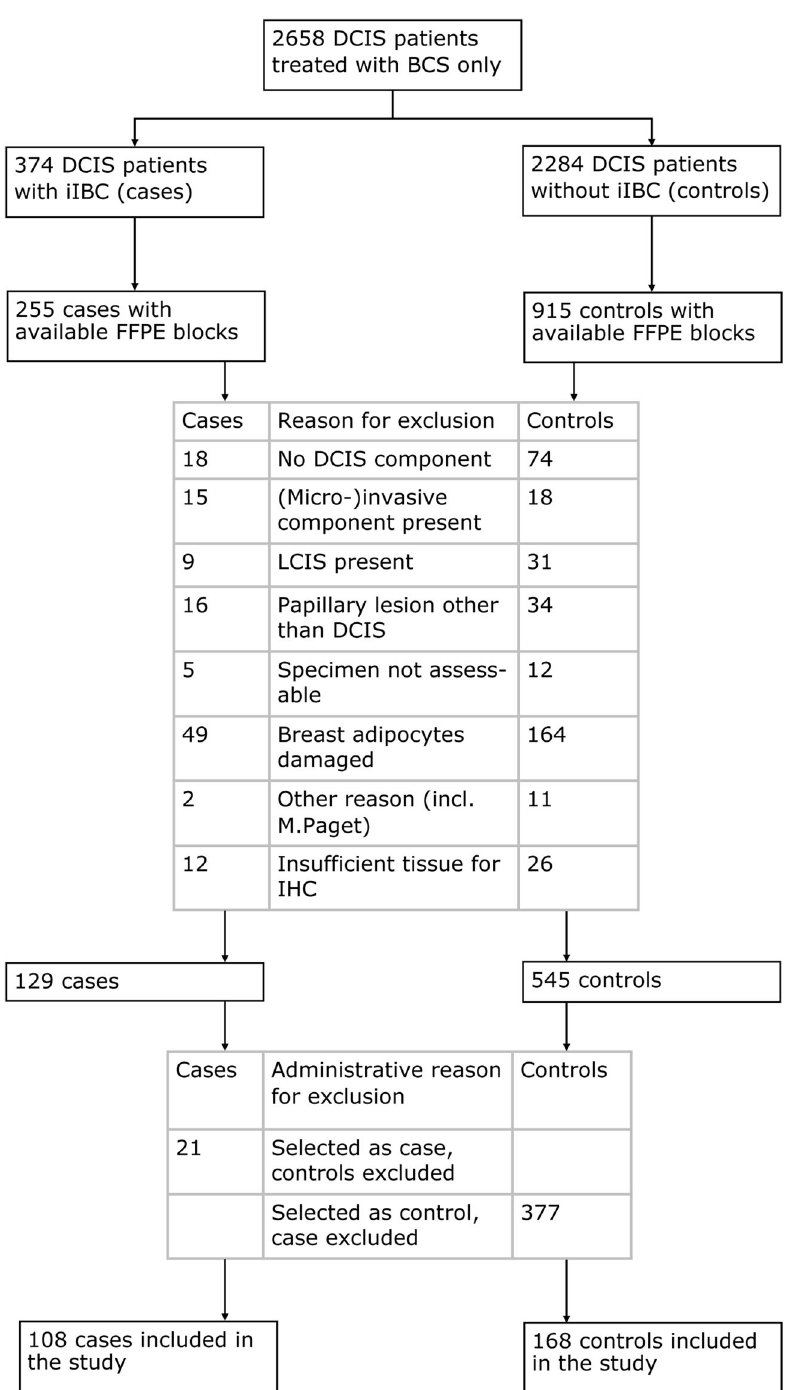
Fig. 1 Diagram of women with DCIS included in the analysis. Abbreviations BCS: breast conserving surgery; iIBC: ipsilateral invasive breast cancer; FFPE: formalin- fi xed paraf fi n-embedded; LCIS: lobular carcinoma in situ; IHC: immunohistochemistry. The cohort consisted of 2658 women with primary DCIS treated with BCS alone, of which 374 women developed subsequent iIBC, as fi rst invasive cancer. At the start of the study, we received FFPE blocks of 255 and 915 controls. Some patients were excluded because no matched case or control was available for the case – control set they were part of. In total, 108 cases and 168 controls were included in the